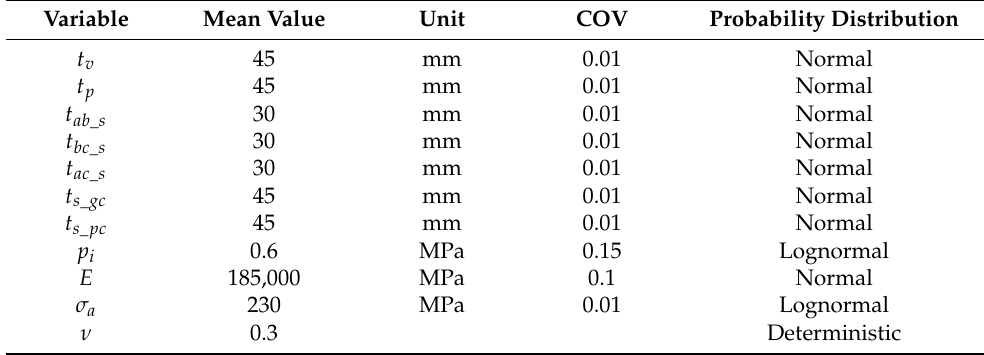
Table 2. Design variables for time-dependent structural reliability analysis.